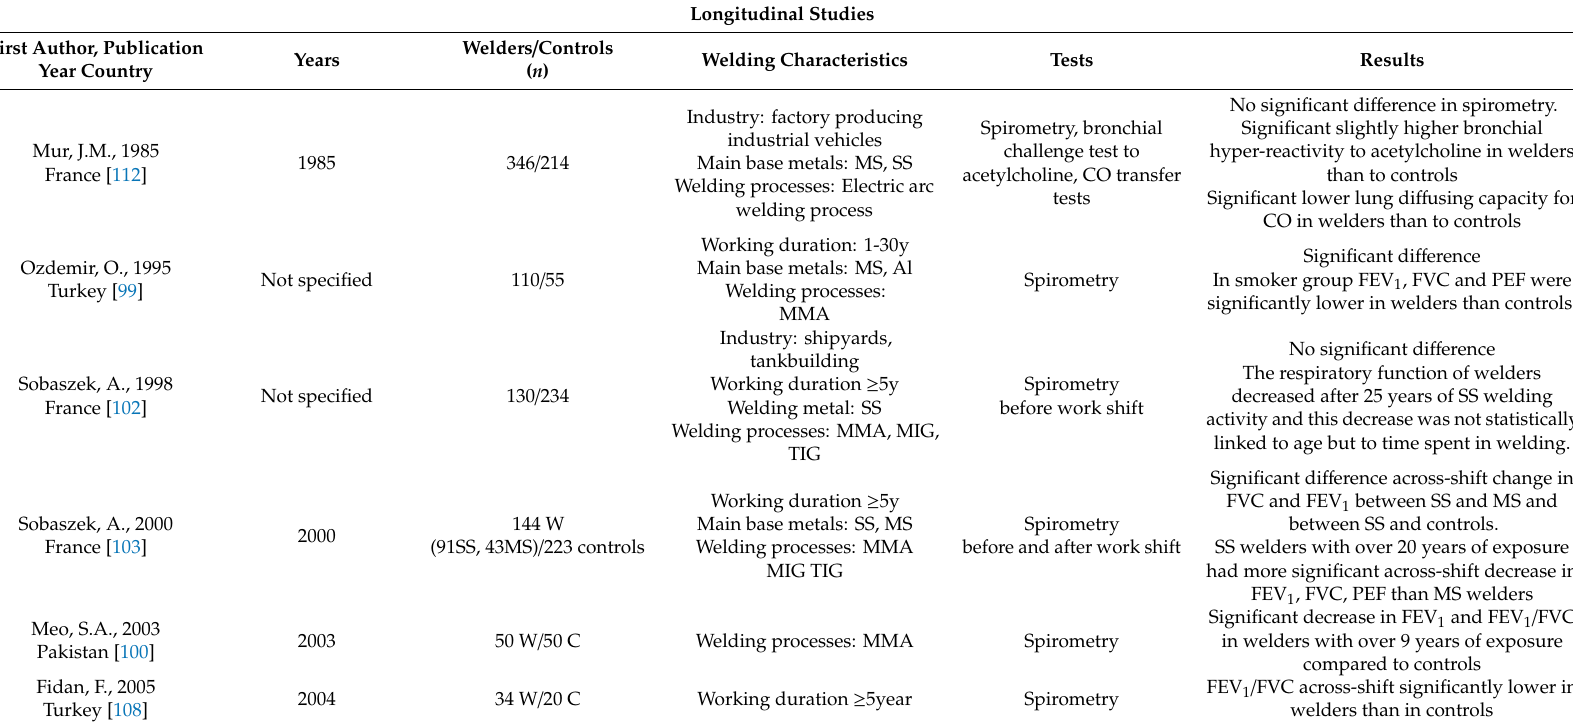
Table 3. Cross-sectional study of lung function in